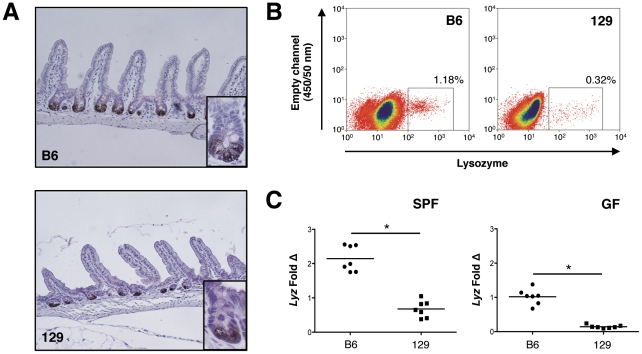
129 mice possess fewer Paneth cells than B6 mice.(A) Lysozyme (Lyz) staining of ileal tissue shown at 20× magnification from B6 and 129 mice. Inset shows high power view (40×) of single crypt. (B) Flow cytometry was used to quantify Lyz+ cells from the ileal epithelium of B6 and 129 mice. Data are representative of 3 independent experiments. (C) Lyz transcripts were measured using quantitative RT-PCR of ileal RNA extracts from SPF and GF mice. Copy number is normalized to Gapdh, and fold change is relative to the GF B6 group (*P<.0001).